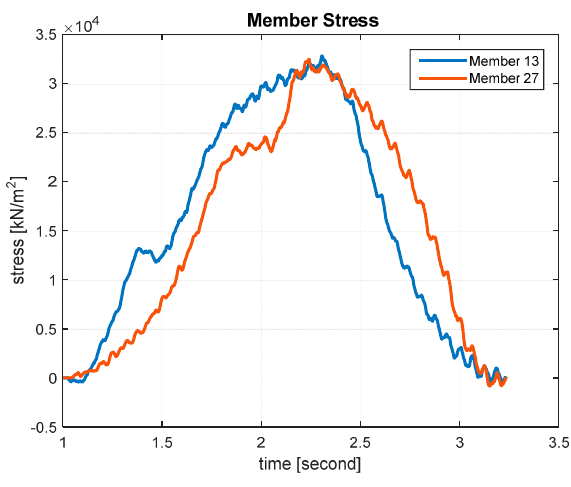
Figure 4. Stress history of Members 13 and 27.